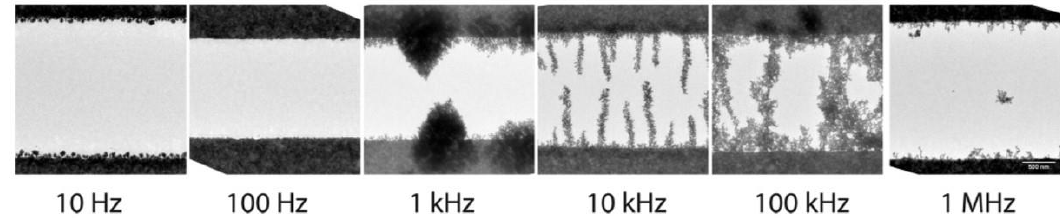
Figure 9. TEM images of Au NP assemblies formed by the application of an AC electric field at various frequencies: 10 Hz–1 MHz. Reproduced with permission from Reference [71] (Copyright 2008 American Chemical Society).